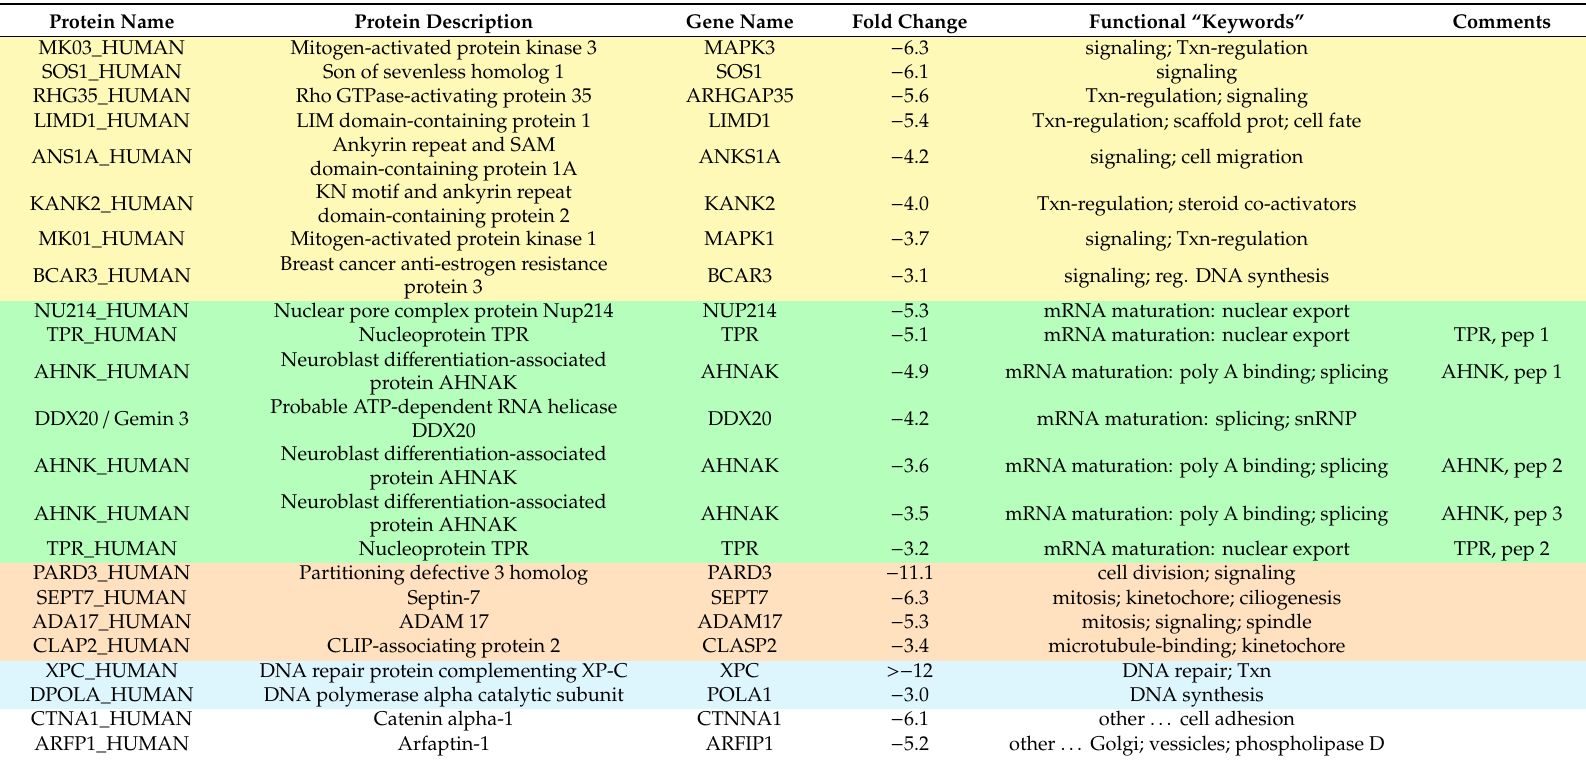
Table 1. Proteins yielding phospho-peptides that decrease > 3-fold after CDK12 inhibition. Proteins that produced phospho-peptides decreasing 3-fold or more after 30 min of 1-NM-PP1 treatment are grouped in five broad functional categories described by the terms in the “Keywords” column. Within a category, the proteins are listed in decreasing order of the fold change of the P-peptide(s) produced; peptide sequences are presented in Supplementary File I, Table S5. TPR and AHNK produced > 1 P-peptide each (Comments column). Colors indicate functional categories (yellow = transcription regulation / signaling; green = mRNA maturation; orange = cell division / mitosis; blue = DNA